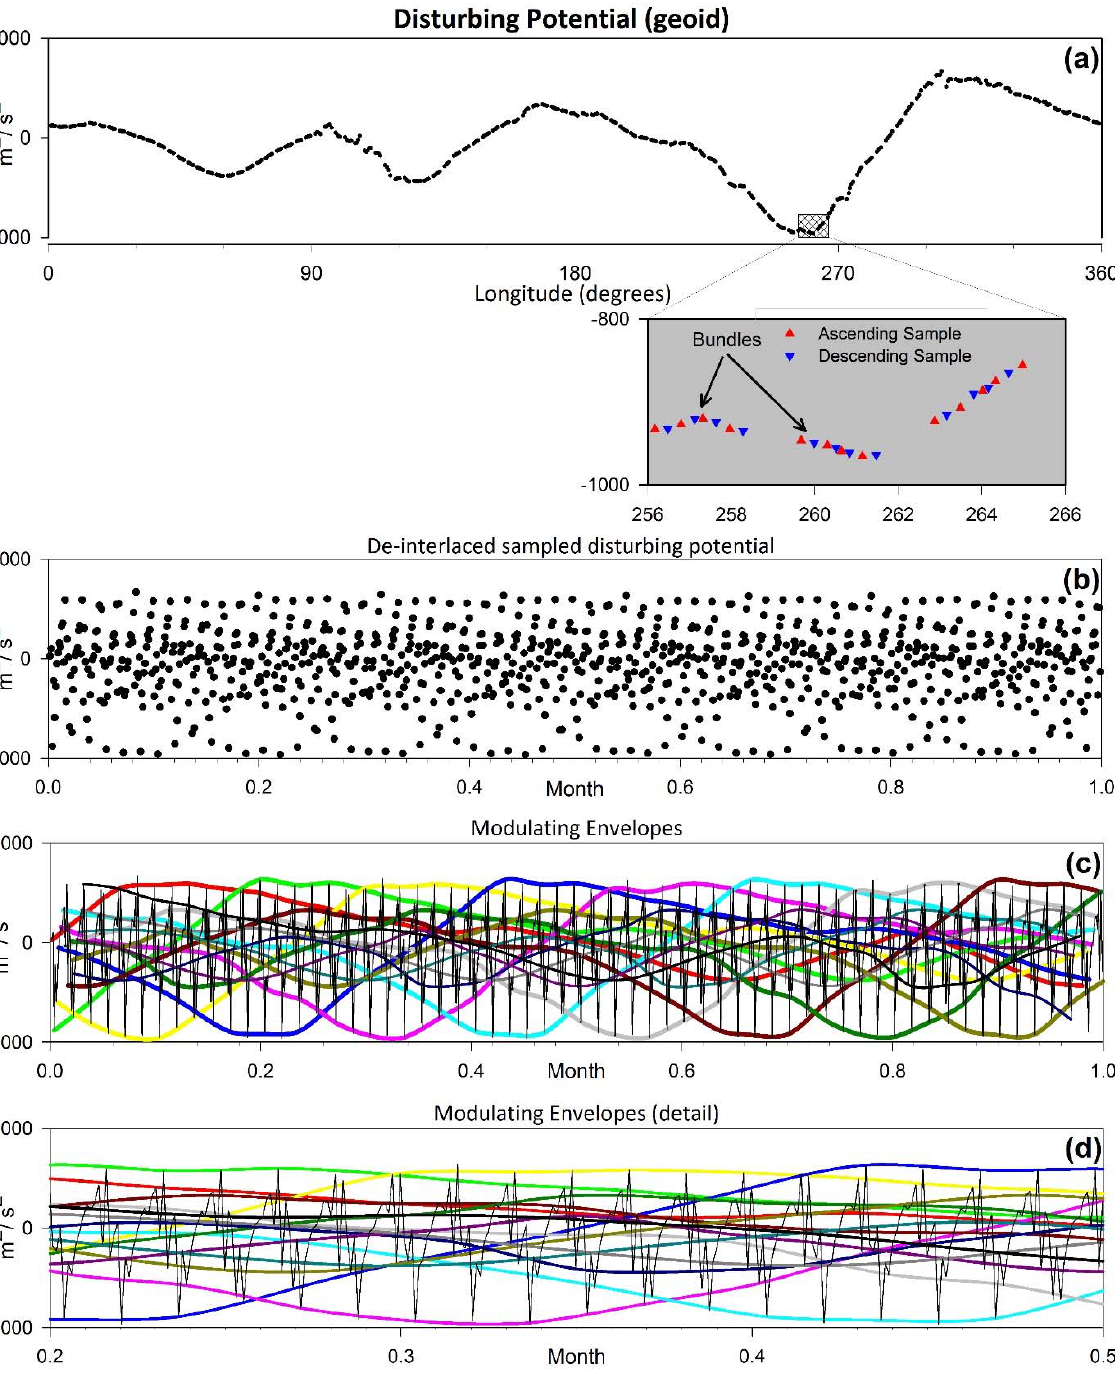
Figure 3. ( a ) Deinterlaced latitudinal profile of the disturbing potential at φ = + 10 ◦ . Sample points in June 2009 are in red (ascending node) and blue (descending node); ( b ) Sample points deinterlaced in space; ( c ) The n = 15 modulating envelopes in colour and the modulated signal; and ( d ) detail of the modulating envelopes and the modulated sampled signal (black